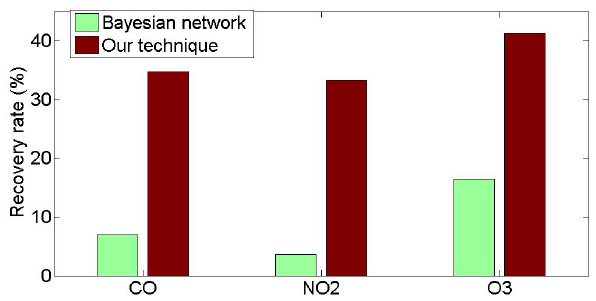
Figure 9. The percentage of successfully cleaned